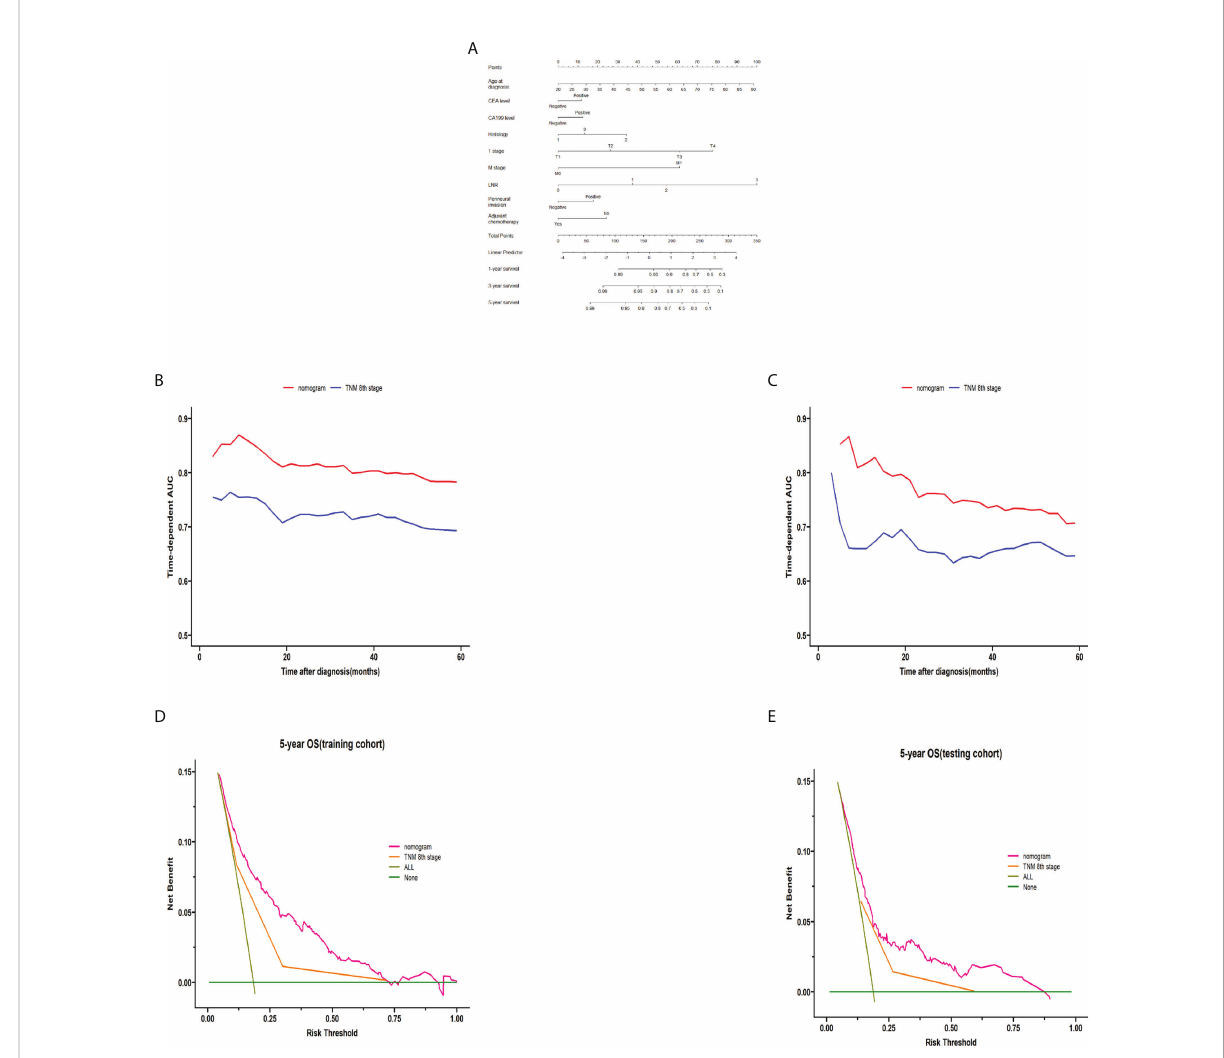
FIGURE 6 Construction and validation of the nomogram. The nomogram for predicting 1-, 3-, and 5-year survival in colon cancer (A) . A web-based tool based on the formulated nomogram is available at https://coloncancernomogram20220118.shinyapps.io/DynNomapp/. The time-dependent AUCs using the nomogram to predict 5-year overall survival probability in both the training and testing cohorts are shown in panels (B, C) , respectively. Decision curve analysis of the nomogram and TNM 8th edition staging for the survival prediction of patients with colon cancer are also shown. The 5-year survival bene fi t in both the training and testing cohorts is shown in panels (D, E) , respectively. For LNR, 0 indicates LNR = 0, 1 indicates LNR = 0 – 0.3, 2 indicates LNR = 0.3 – 0.7, and 2 indicates LNR >0.7. For the histology, 1 indicates adenocarcinoma, 2 indicates mucinous adenocarcinoma, and 3 indicates mixed cell adenocarcinoma. AUC, area under the curve; TNM, tumor-node-metastasis; LNR, lymph node